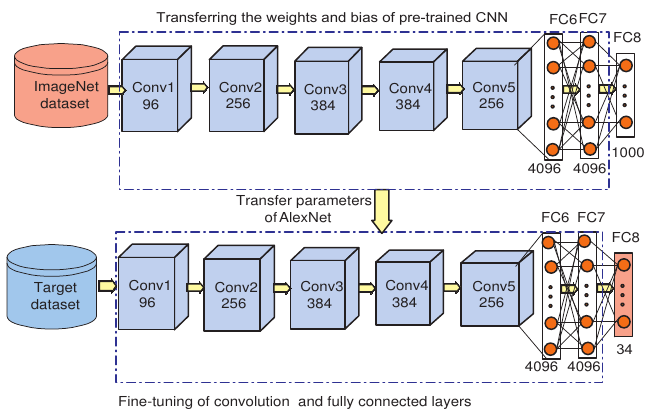
Figure 3. Fine-tuning process using pre-trained AlexNet on target hand gesture